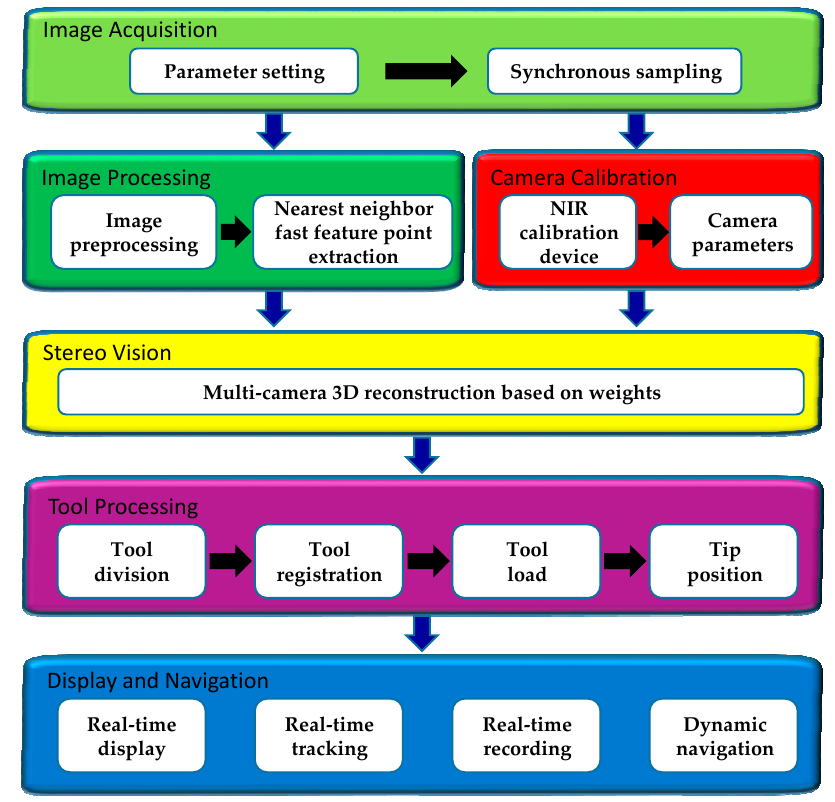
Figure 4. The flow chart of the